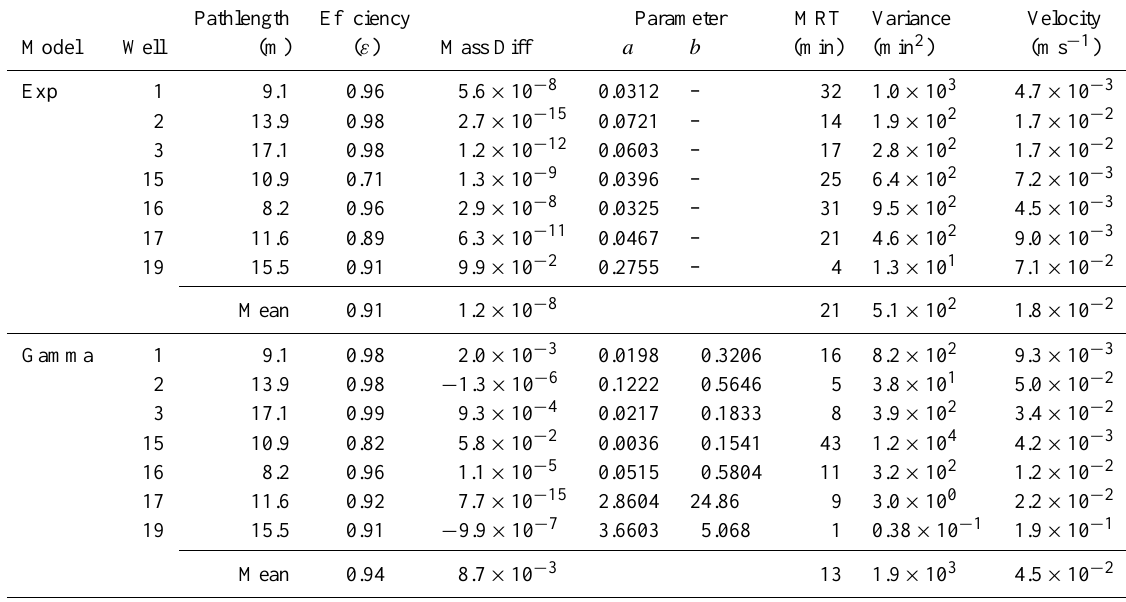
Table 2. Modeling results of pressure transport for no-salt test. The best-fit value for the time delay parameter d was zero for all tests. Negative values of Mass Diff (proportional mass difference) indicate an over-prediction of mass in the tails of residence time distributions.